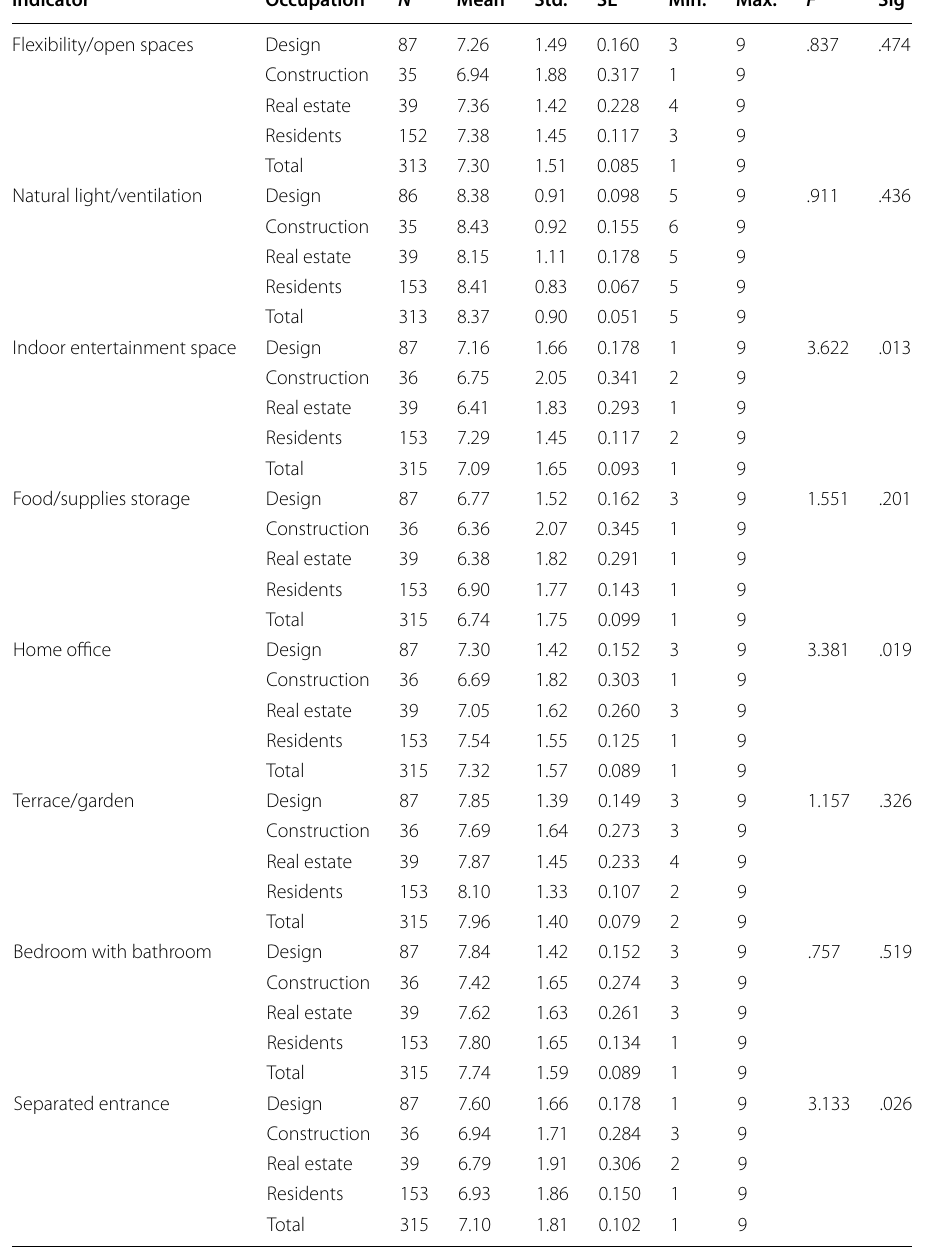
Table 6 One-way ANOVA